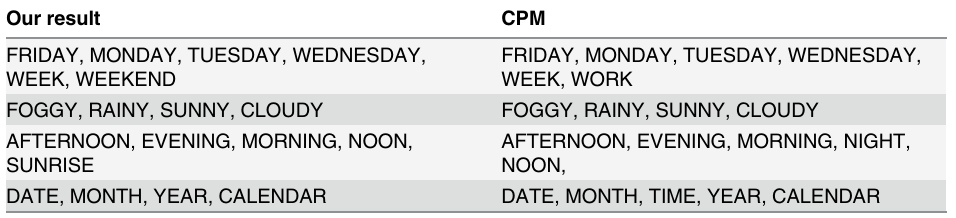
Table 6. The communities associated with the word DAY with K determined automatically. Our